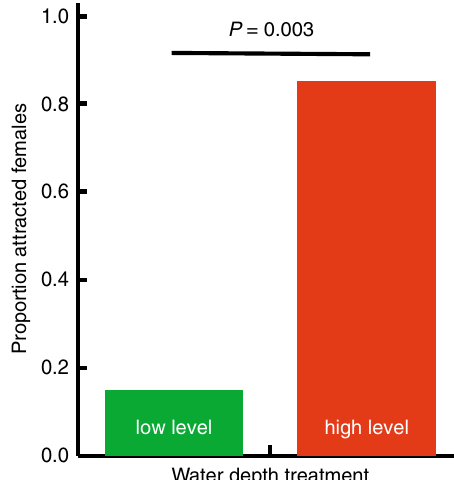
Fig. 2 Females prefer males that call from the highest water levels. Results from choice experiments with 20 females. The P -value was calculated using